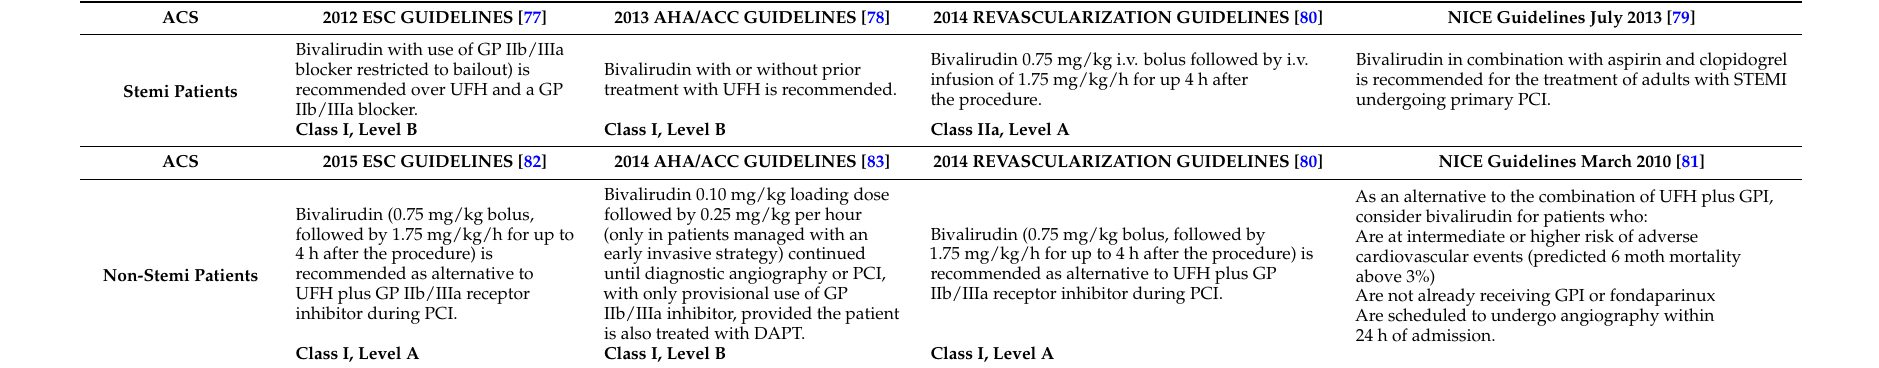
Table 3. Recommendations of clinical guidelines for STEMI and non-STEMI